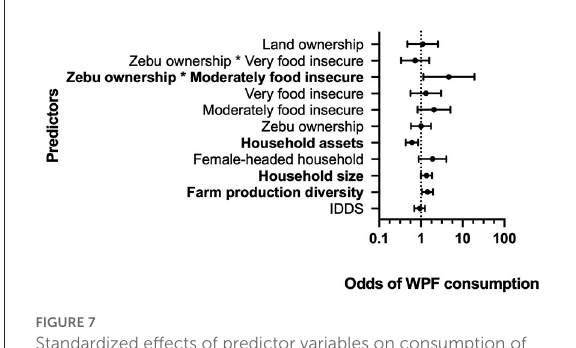
FIGURE7 Standardized effects of predictor variables on consumption of wild plant foods (WPFs). Points represent the odds ratio estimates with upper and lower 95% confidence intervals. Bolded predictors indicate significance at the p < 0.05 level. The value of 1 on the x-axis (dashed line) is equivalent to no effect. Results based on a random effects model of data from 302